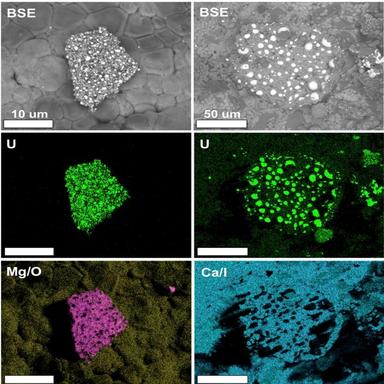
Images and elemental X-ray maps of two types of particle agglomerations present in the slag.